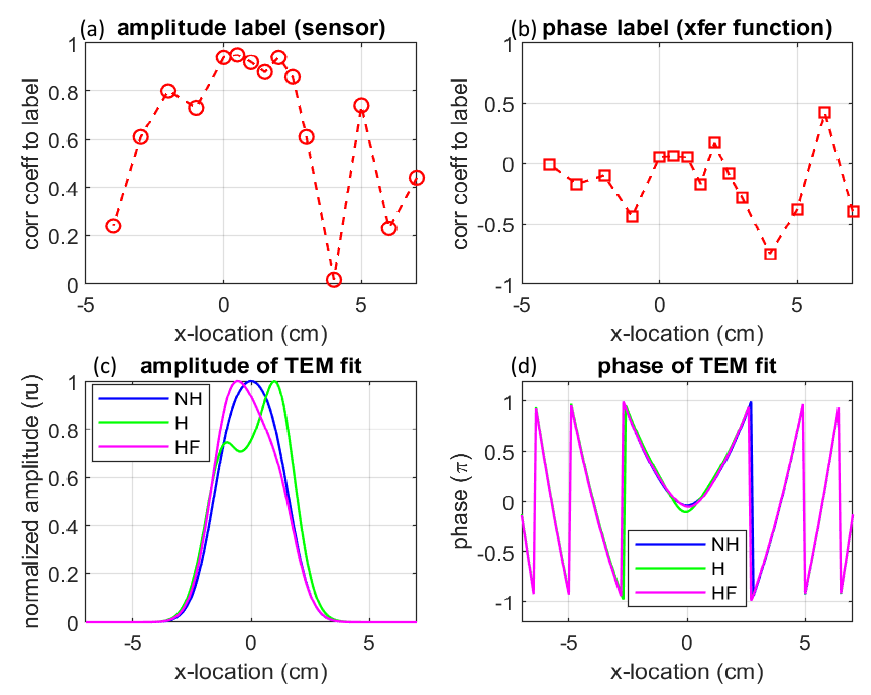
Figure 21. ( a ) Amplitude correlation to label, ( b ) phase correlation to label, ( c ) amplitude of Hermite– Gaussian fits, ( d ) phase of Hermite–Gaussian